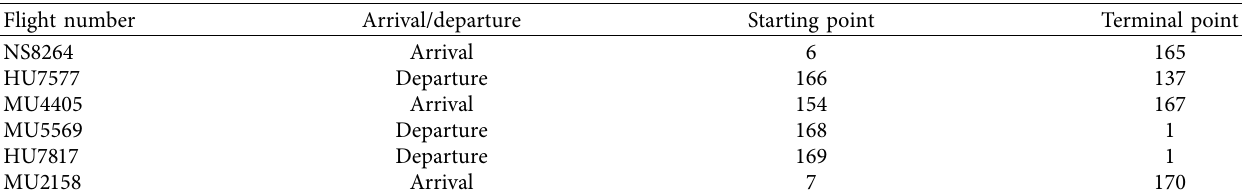
Figure 12: Xi’an Xianyang airport structure simplified diagram. Table 1: Flight taxi